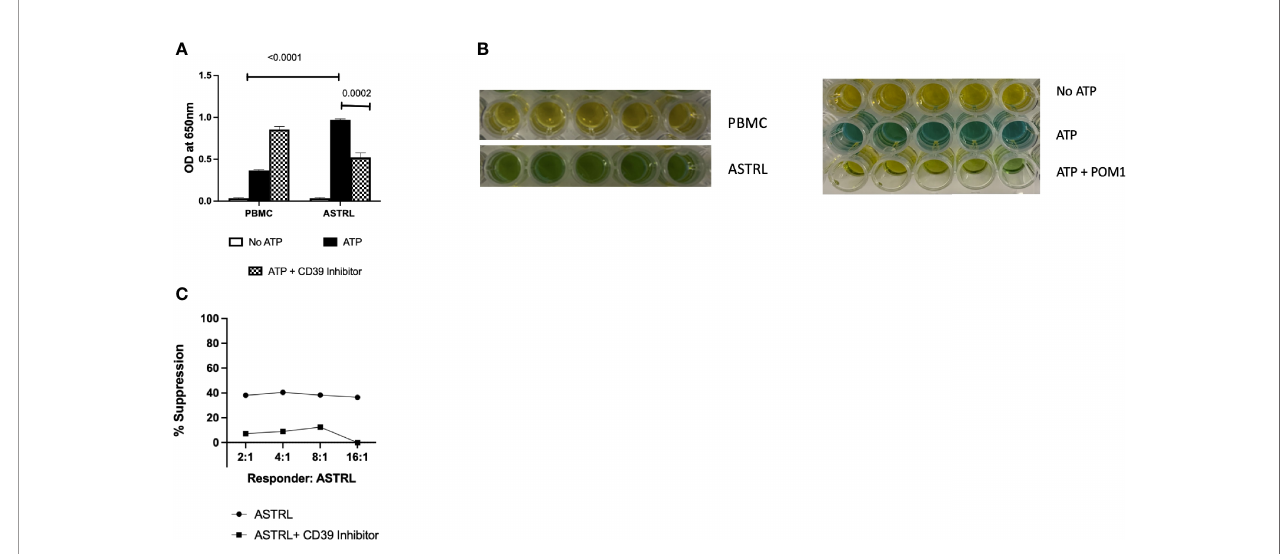
FIGURE 4 | ASTRL hydrolyze extracellular ATP in a CD39 dependent manner. (A) ASTRLs Extracellular ATP (eATP) hydrolysis by ASTRL and in presence or absence of POM1, a CD39 inhibitor. (B) Malachite Green assay, that detects the presence of inorganic phosphate (green color) resulting from ATP hydrolysis, showing eATP hydrolysis by ASTRL and PBMC. (C) Effect of CD39 inhibition (presence of POM1) on suppressive effect of ASTRL on antigen speci fi c proliferation of responder